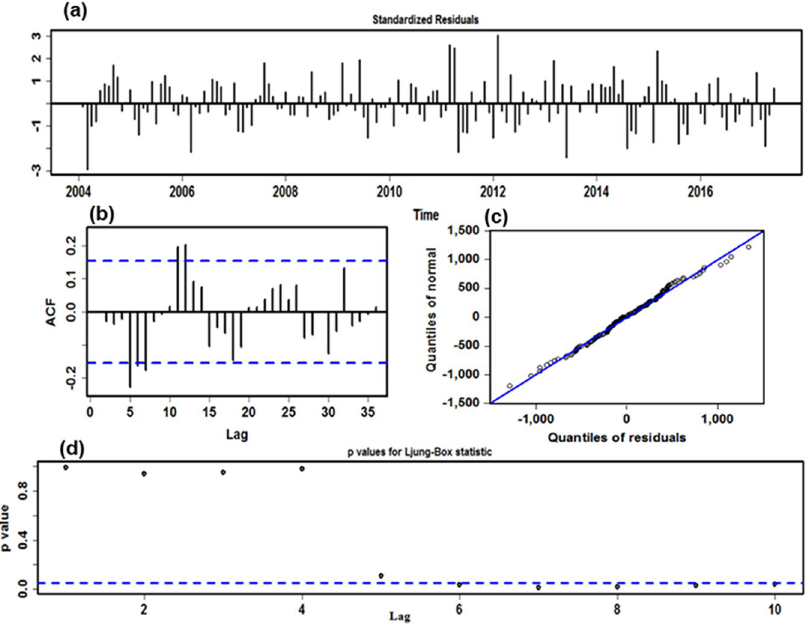
Figure 3. Residual diagnostic plots of ETS (A,N,A) model. ( a ) Standardized residuals. ( b ) Autocorrelation function (ACF) plot of the time-series residuals. ( c ) Normal Q-Q plot for determining the normality of the time-series residuals. ( d ) P values for Ljung-Box statistic. On the basis of the graphs, it seems that existing occult information are still required to explore.